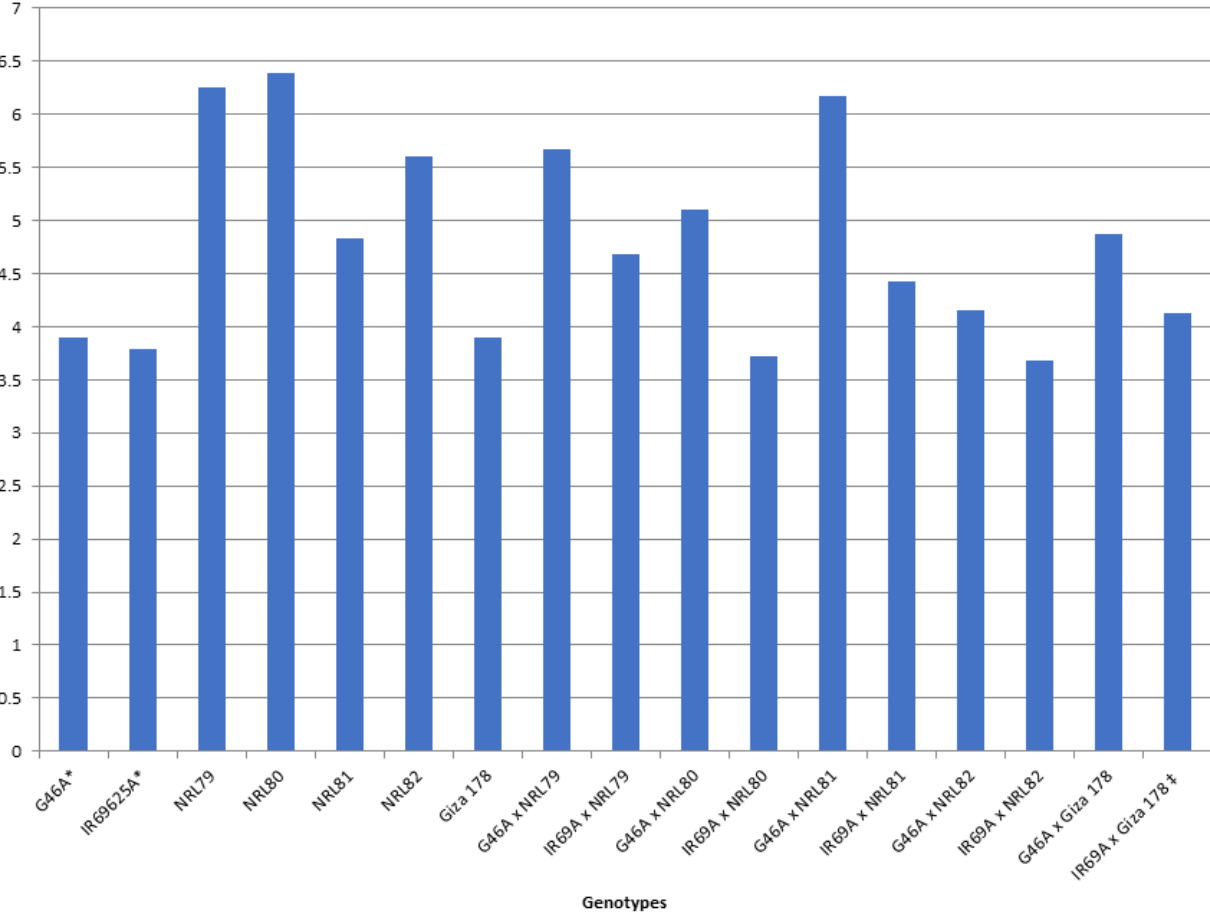
Figure 4. The mean performance for the panicle weight of the studied genotypes. *: The traits were recorded on maintainer lines that were related to CMS lines, ‡: Hybrid check.